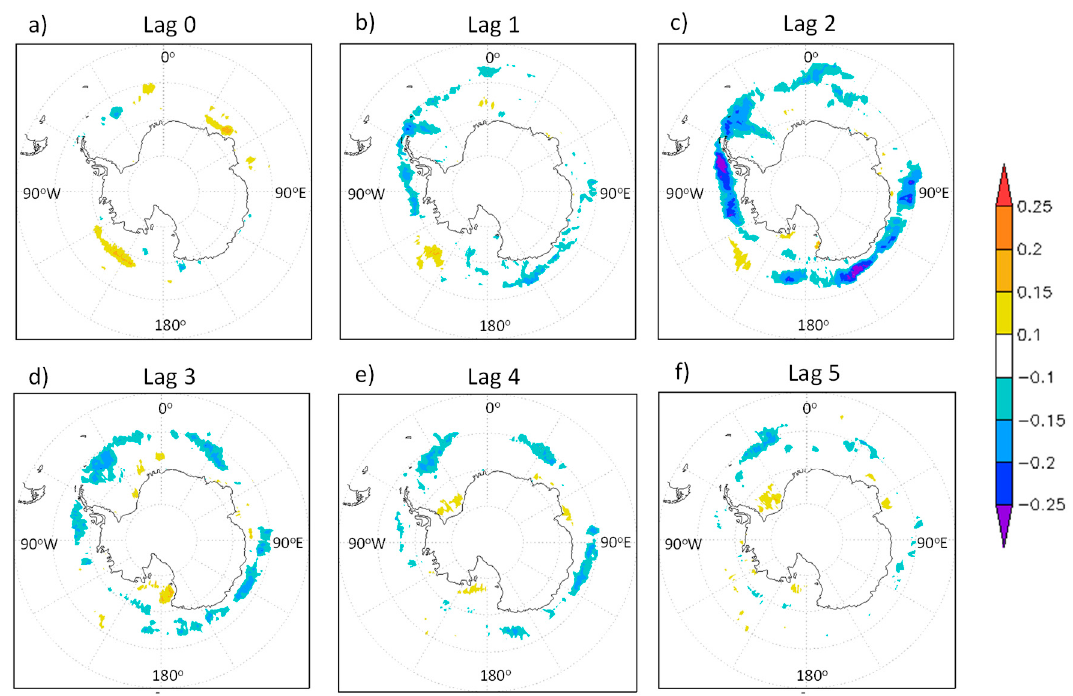
Figure 6. Spatial pattern of the lagged correlation coefficients between the anomalies in each austral sea of the moisture sink ((E − P)i10 < 0, but multiplied by -1) in January using ( a ) the SIC from January for lag-0 (0 month lag), ( b ) the SIC from February for lag-1 (1-month lag), (c ) the SIC from March for lag-2 (2 month lag), ( d ) the SIC from April for lag-3 (3 month lag), ( e ) the SIC from May for lag-4 (4 month lag), ( f ) the SIC from June for lag-5 (5 month lag). Only the statistically significant values ( p -value < 0.05) are shown in the panels. Table 2. Trend of the mean monthly moisture sink and the SIC for each austral sea obtained with the non-parametric test from Mann-Kendall with Sen’s slope. Statistically significant values at the level of 95% are highlighted in